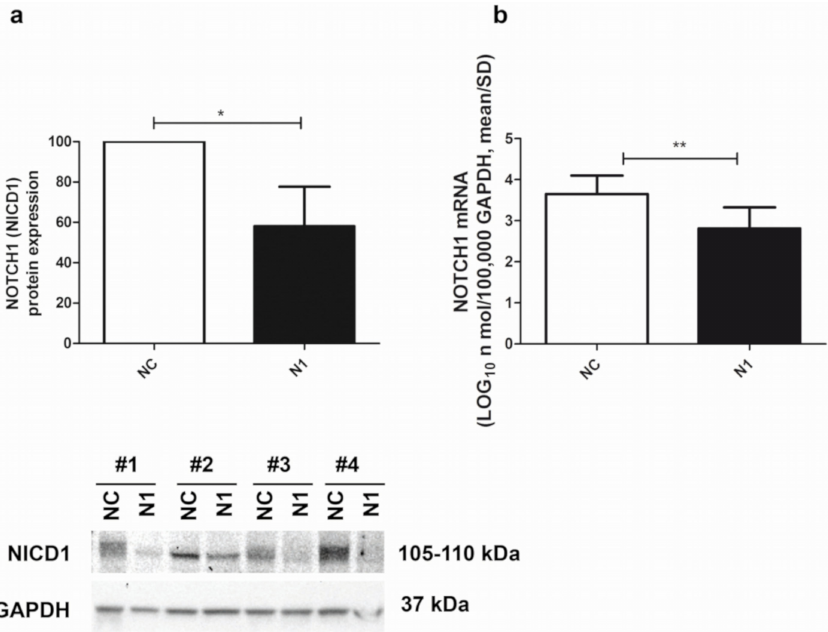
Figure 2. Efficiency of NOTCH1 silencing. ( a ) Cumulative Western blot evaluation of NOTCH1 KD in four different samples (Western blot shown below) as evaluated by assessment of the 110 kDa NICD1 active form at 48 h after transfection (mean ± SD, n = 4) with GAPDH used as a loading control; * p < 0.05. ( b ) NOTCH1 KD in five different samples assessed by real time RT-PCR (mean ± SD, n = 5). NC—control; N1—NOTCH1 silenced chondrocytes; ** p <